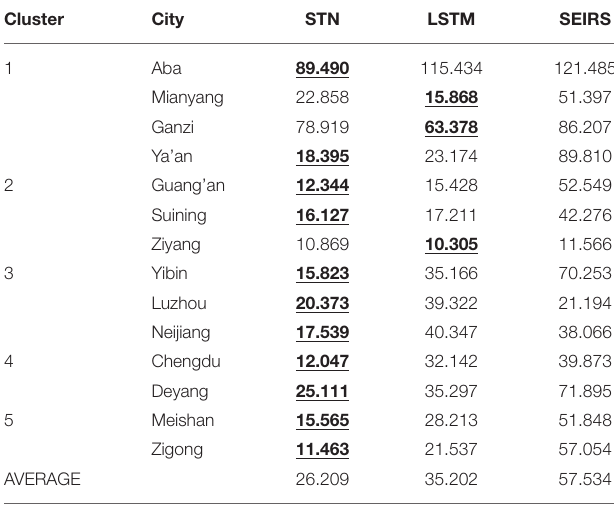
The minimum MAPE value of the three methods for each city is indicated in bold and underlined in the